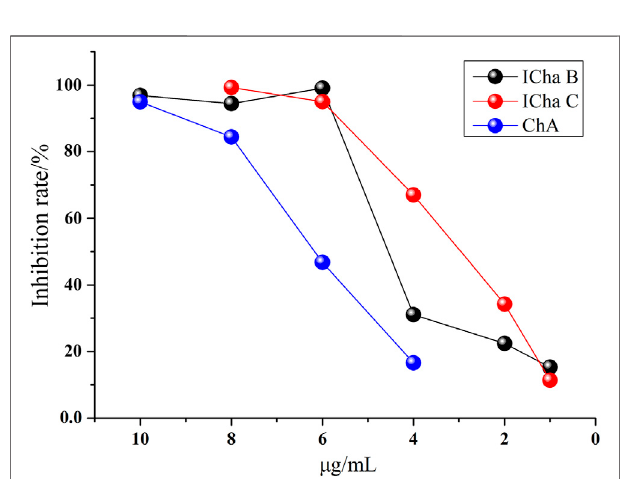
FIGURE 6 | Dose response curves of the COX-2 inhibition rate in the presence of increasing CHA, ICha B, and ICha C concentrations.